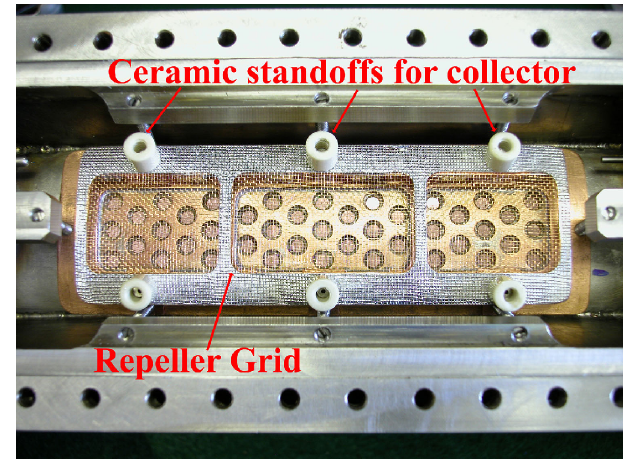
FIG. 1. (Color) Schematic cross section of the electron sweeping diagnostic in a quadrupole magnet. Its principal components are an RFA chamber containing a repeller grid and collector plate concentric with the circular beam pipe, holes in the beam pipe at the entrance to the RFA chamber, and a high voltage sweeping electrode.